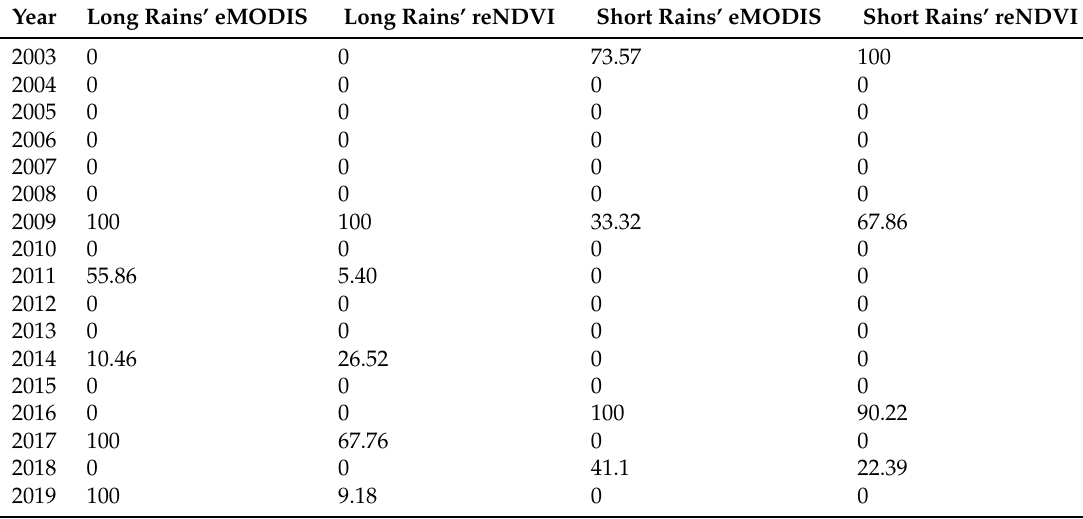
Figure 7. Cumulative NDVI ( ∑ NDVI) and index values (Z ∑ NDVI) compared to payout thresholds for the one selected example UAI for long rains (top) and short rains (bottom). Table 1. Calculated hypothetical percent payouts for the selected UAI (Kapchok ward in West Pokot county) in Figure 7. For this UAI, eMODIS and reNDVI triggered all payouts at the same time, but there were differences in payout